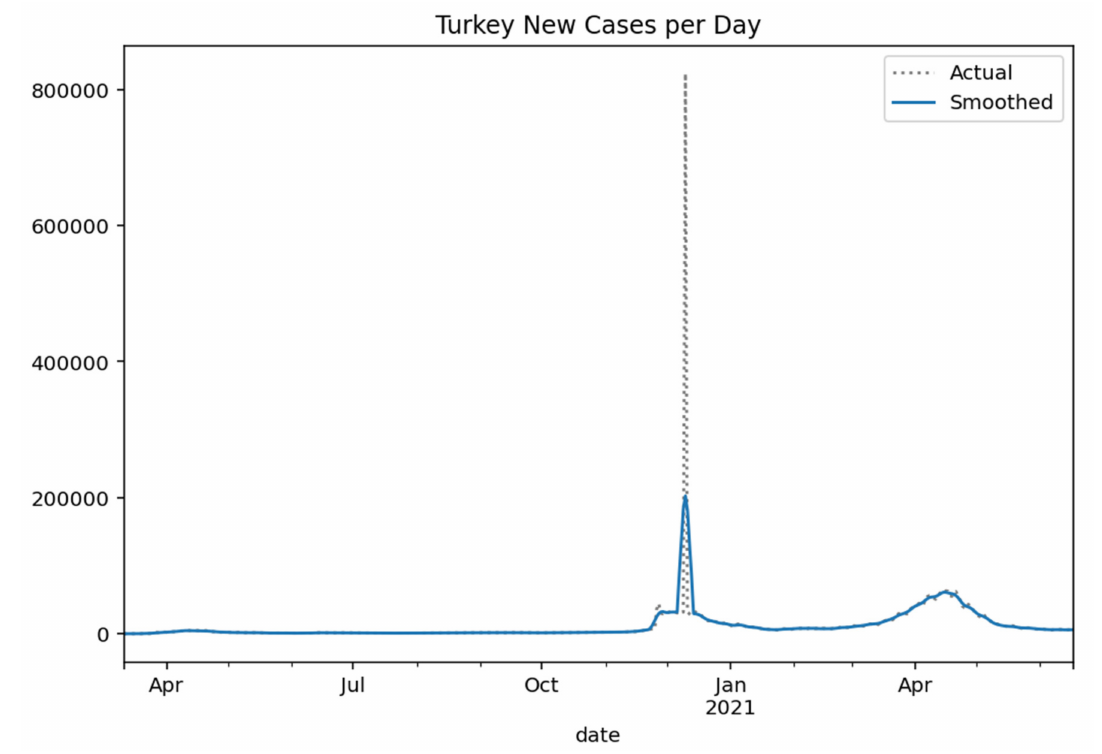
Figure 4. Turkey new cases per day (Gaussian smoothed).